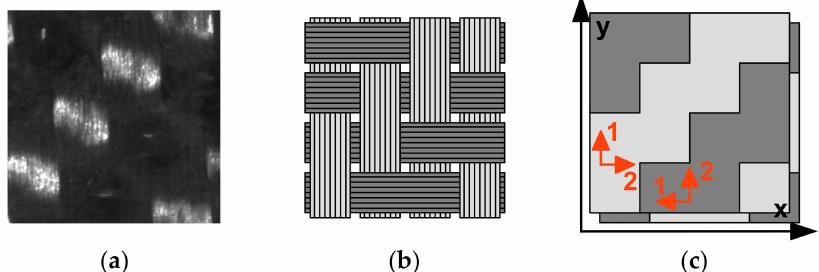
Figure 2. Progressive abstraction of the 2 × 2 twill weave unit cell: ( a ) imaging of the specimen during testing; ( b ) schematic representation, highlighting the vertical (warp) and horizontal (weft) fiber directions; ( c ) simplified model, with two materials to represent the two orientations and two layers to represent the weave. Global (in black) and local (in orange) material directions are shown. The tensile loading direction is 𝑦 ; 1 is the “fiber direction”, 2 is the “matrix direction”.